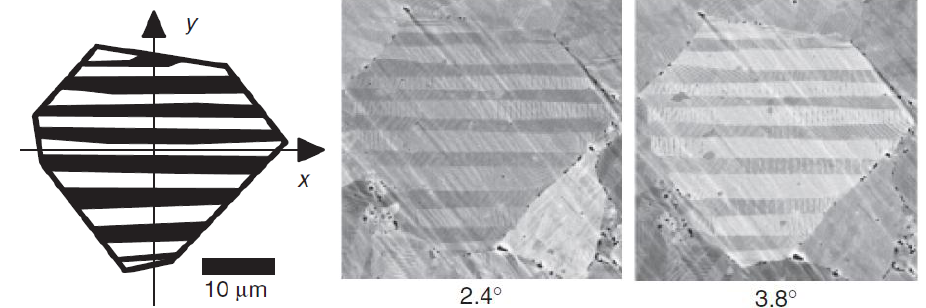
Figure 11. Back-scattered electron images showing effect of specimen tilt on domain observation in (Na,K)NbO (Gruner and Shen, 2010 3